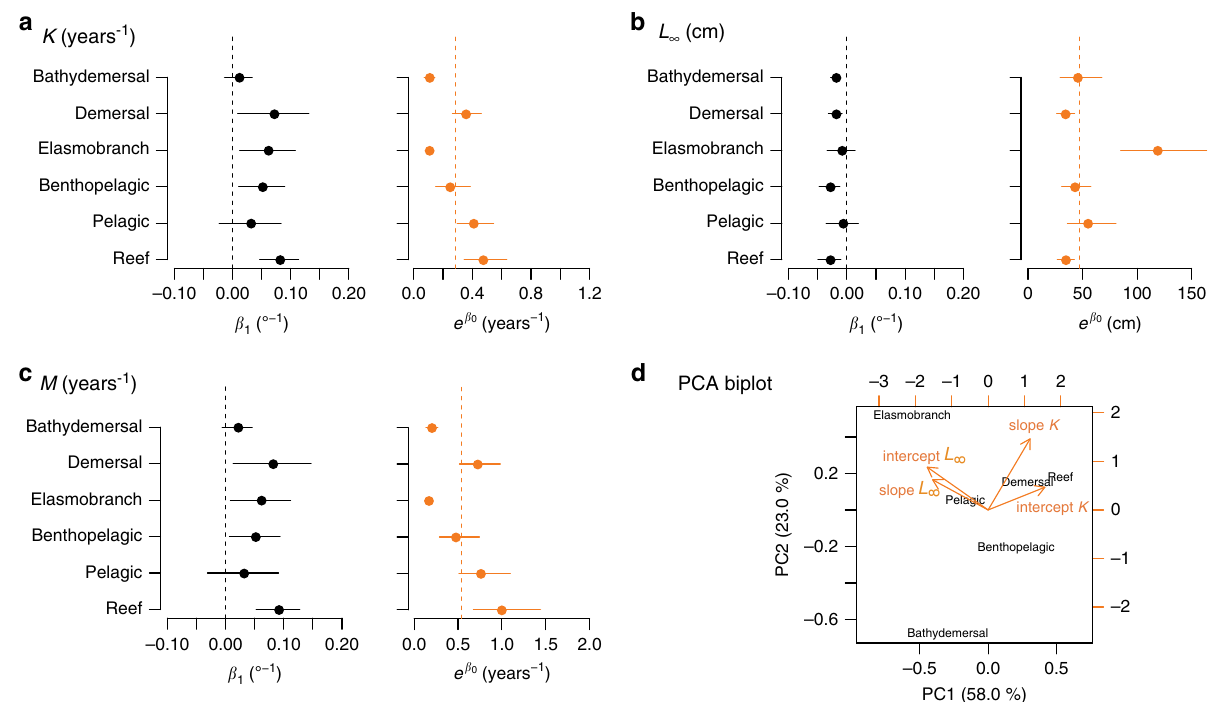
Fig. 3 Differential temperature effects on life-history traits among six groups of Indo-Paci fi c fi shes. Temperature effects on three life-history parameters, K , L ∞ , and M (at A 50 ) ( a – c ), are quanti fi ed by fi tting a linear mixed-effect model for each group with mean-centered SST as the fi xed-effect predictor and a ln-transformed life-history parameter as the response. The slopes ( β 1 ) and back-transformed intercepts (e β 0 ) for the six groups of fi shes are plotted as the point measures with the 95% con fi dence intervals as error bars. Vertical dashed lines are reference lines corresponding to β 1 = 0 (i.e., no temperature sensitivity) and e β 0 = fi xed-effect intercepts pooling all species (mean trait value evaluated at species-speci fi c mean SST). Ordination of the temperature effects on ln K and ln L ∞ for the six groups of fi shes based on principal component analysis (PCA; d ). Black symbols denote the positions of six groups in the reduced dimension space. Orange arrows denote correlation between the temperature effects and the principal components (PC1 and